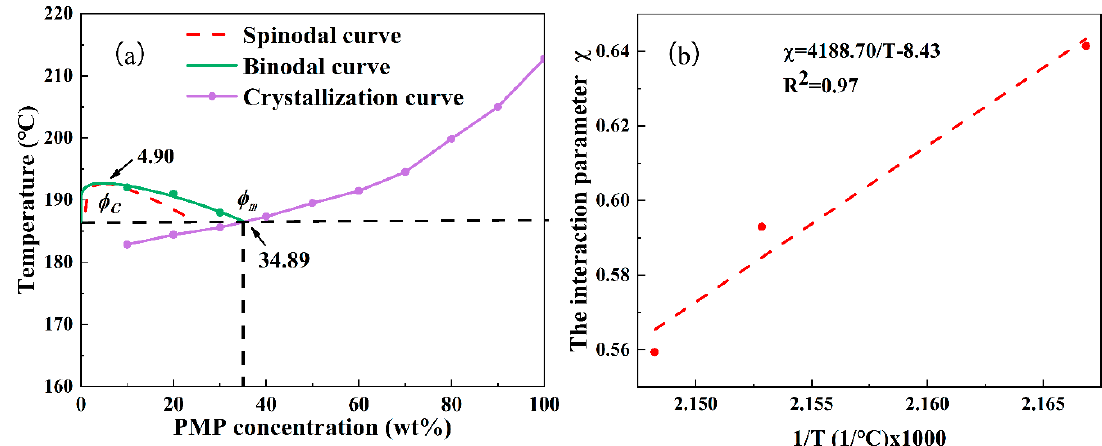
Figure 3. ( a ) The phase diagram of the PMP-MA system, and ( b ) the χ versus 1/ T curve of the PMP-MA system.